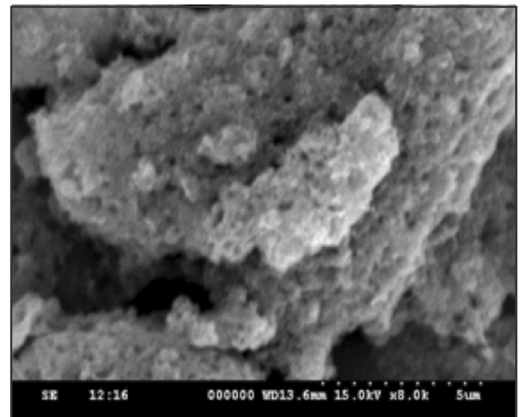
Figure 3. SEM image of porous MnCo 2 O 4 spinel compound.